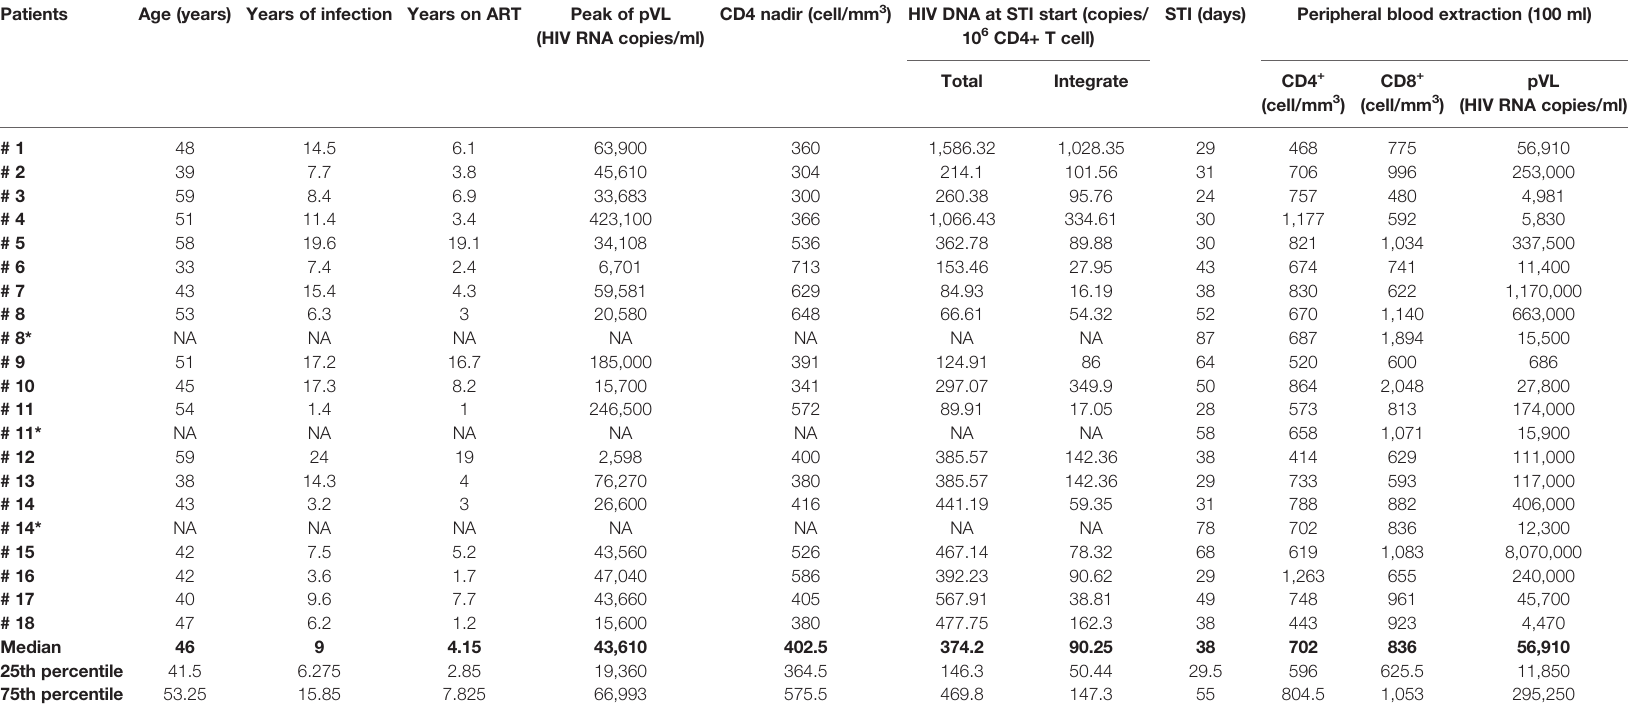
TABLE 1 | Clinical data on ART-treated patients subjected to HIV-1 isolation.